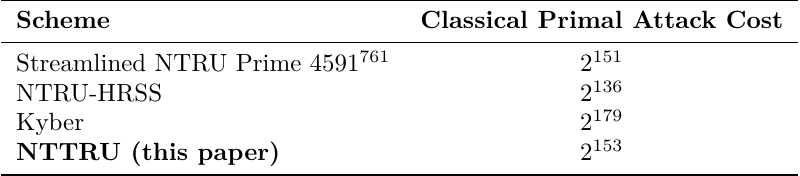
Table 3: Core-SVP cost of the primal attack when using the LSF sieve without Grover